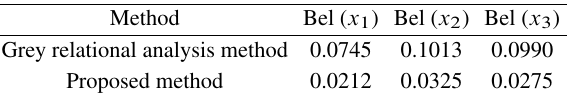
Table 3 Alternatives’ belief measures in two unlike